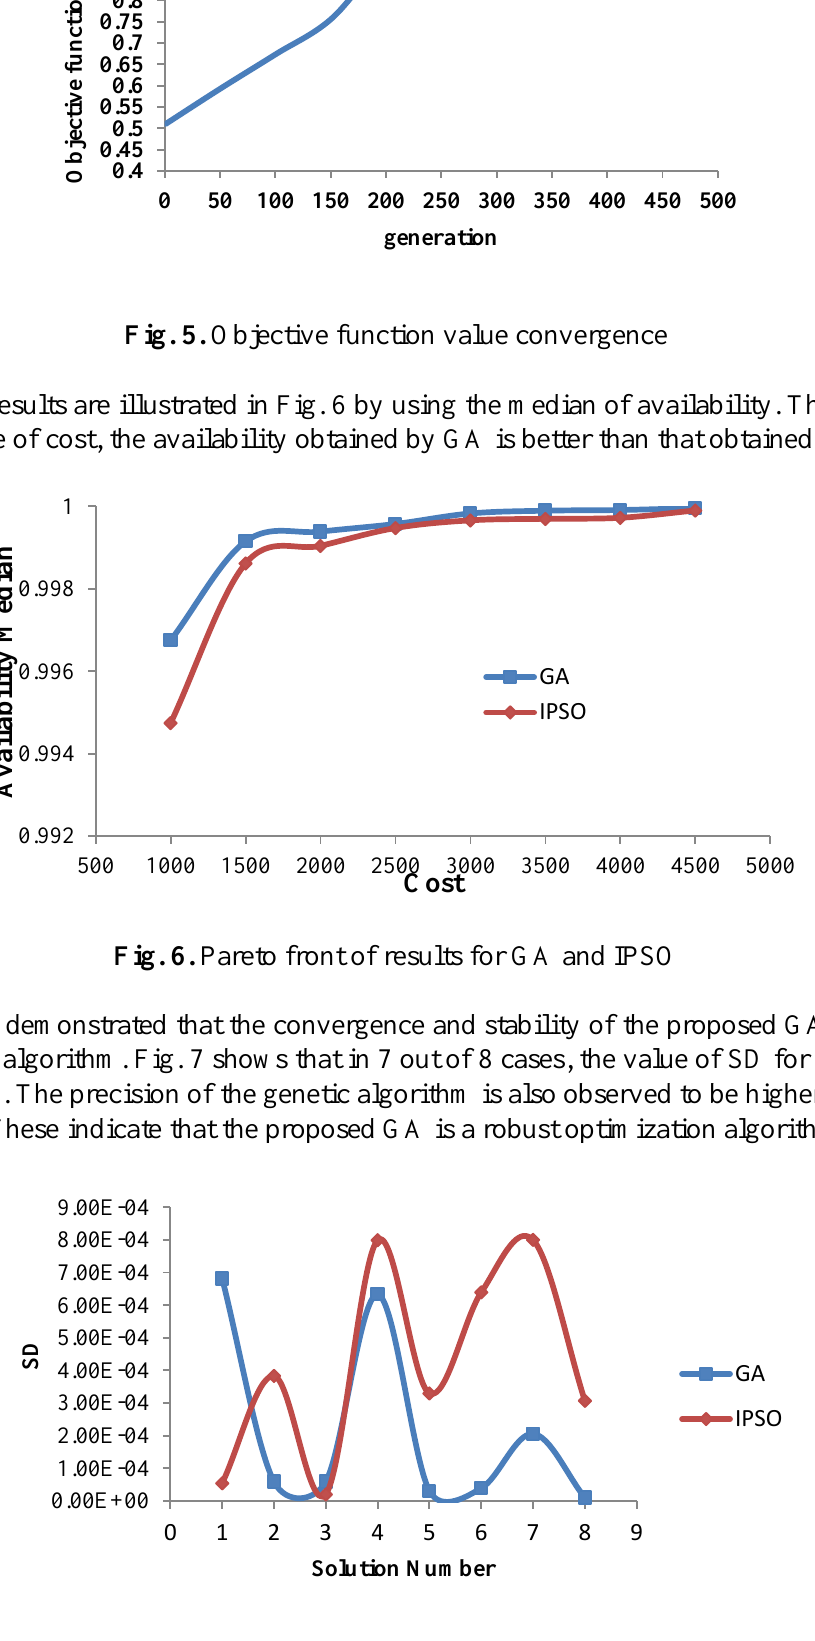
Fig. 7. Compare stability